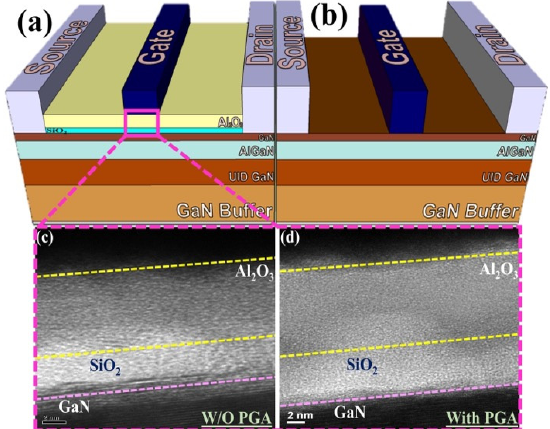
Figure 1. Schematic of ( a ) Al 2 O 3 /SiO 2 MOS–HEMT and ( b ) conventional HEMT. TEM images of the MOS–HEMT ( c ) without gate annealing and ( d ) with gate annealing treatment. MOS–HEMT ( c ) without gate annealing and ( d ) with gate annealing